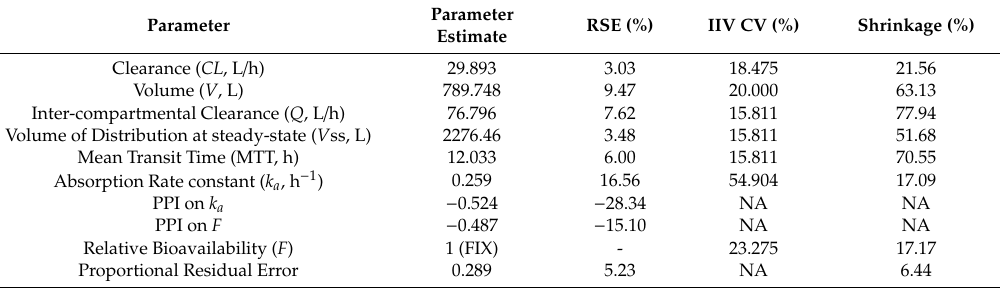
Figure 4. Distribution of η s (ETAs) by the Presence and Absence of Proton Pump Inhibitor, Rabeprazole, in the Dacomitinib Final Model. Table 4. Dacomitinib Final Model Pharmacokinetic Parameters